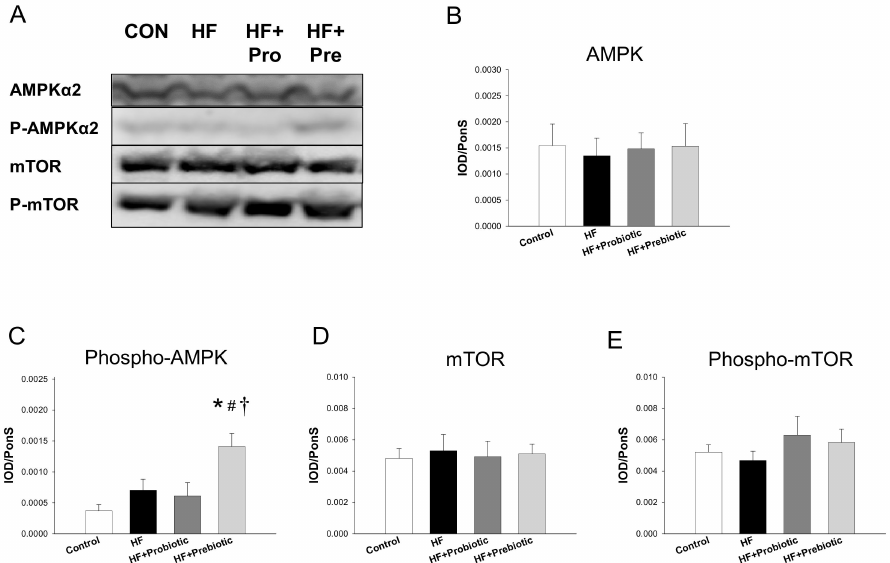
Figure 3. ( A ) Representative western blots showing AMPK α 2 (~63 kDa), phosphorylated AMPK α 2 (~63 kDa), mTOR (~289 kDa), and phosphorylated mTOR (~289 kDa) bands in offspring kidneys with maternal high-fructose (HF) diet and/or treatment with probiotic Lactobacillus casei and prebiotic inulin. Relative abundance of renal cortical ( B ) AMPK α 2, ( C ) phosphorylated AMPK α 2, ( D ) mTOR, and ( E ) phosphorylated mTOR were quantified. N = 7–8/group. * p < 0.05 versus control; # p < 0.05 versus HF; † p < 0.05 versus